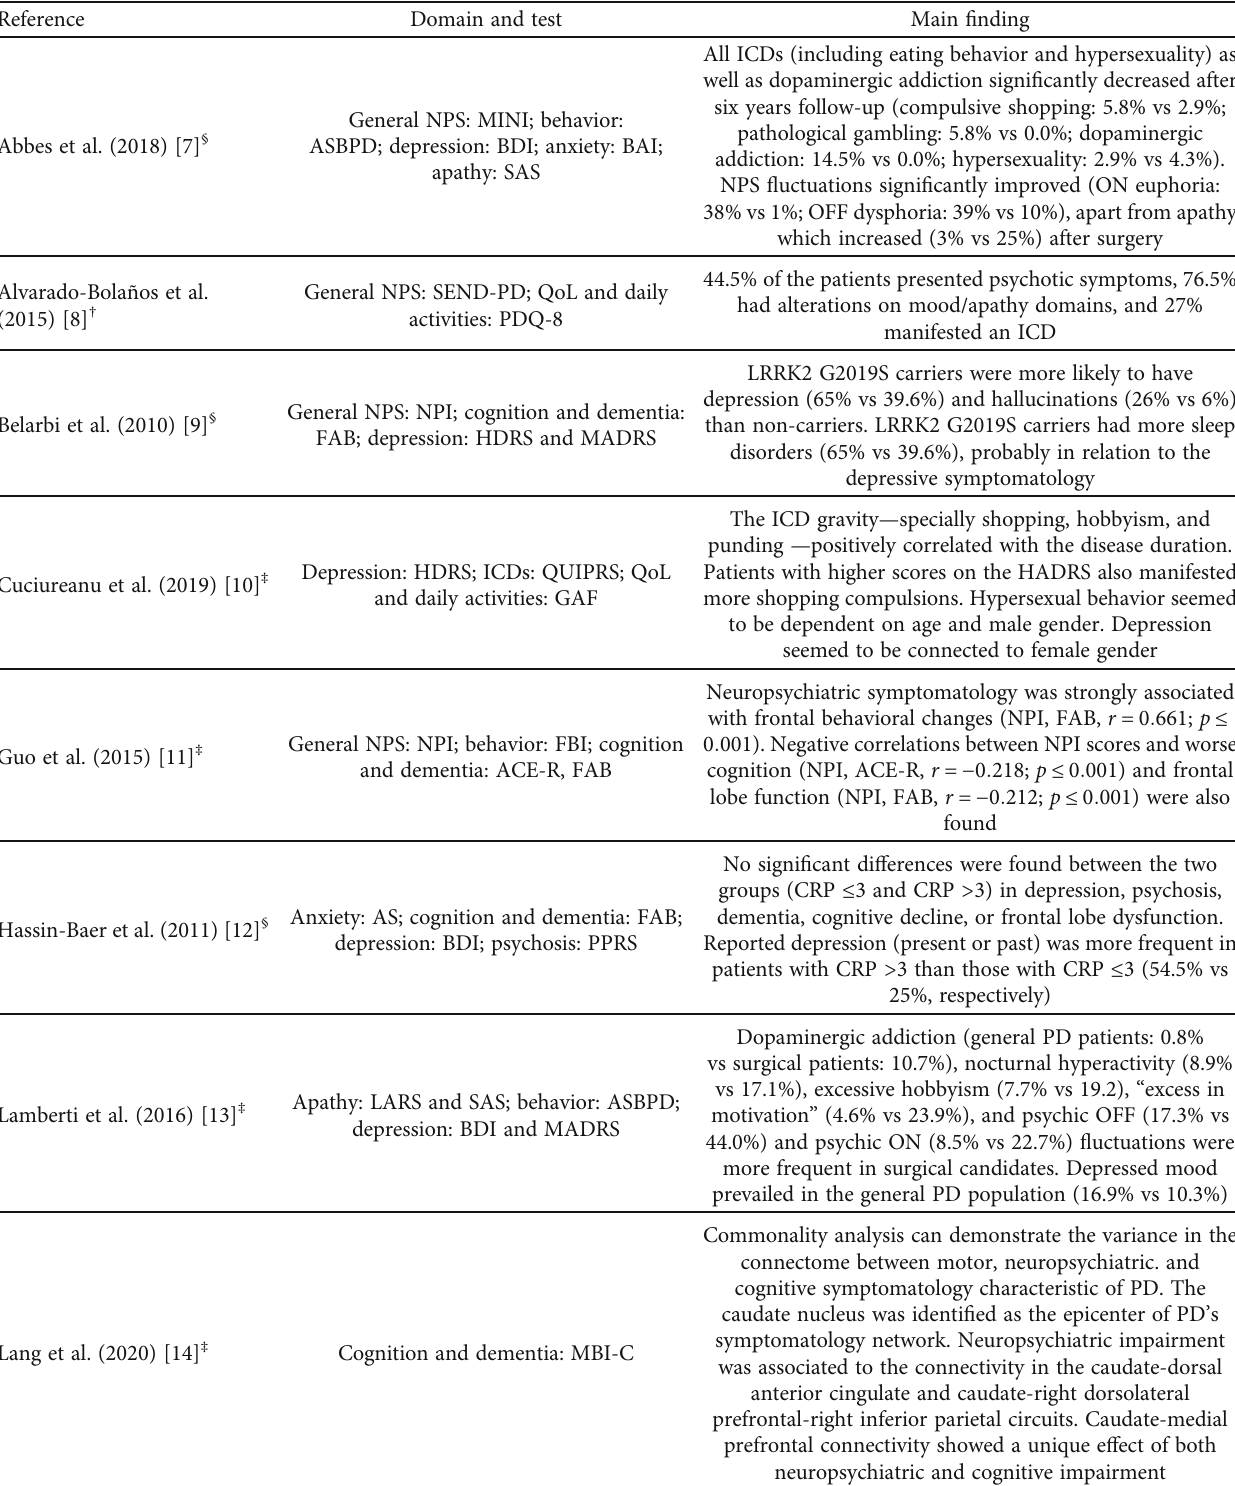
Table 5: Summary of